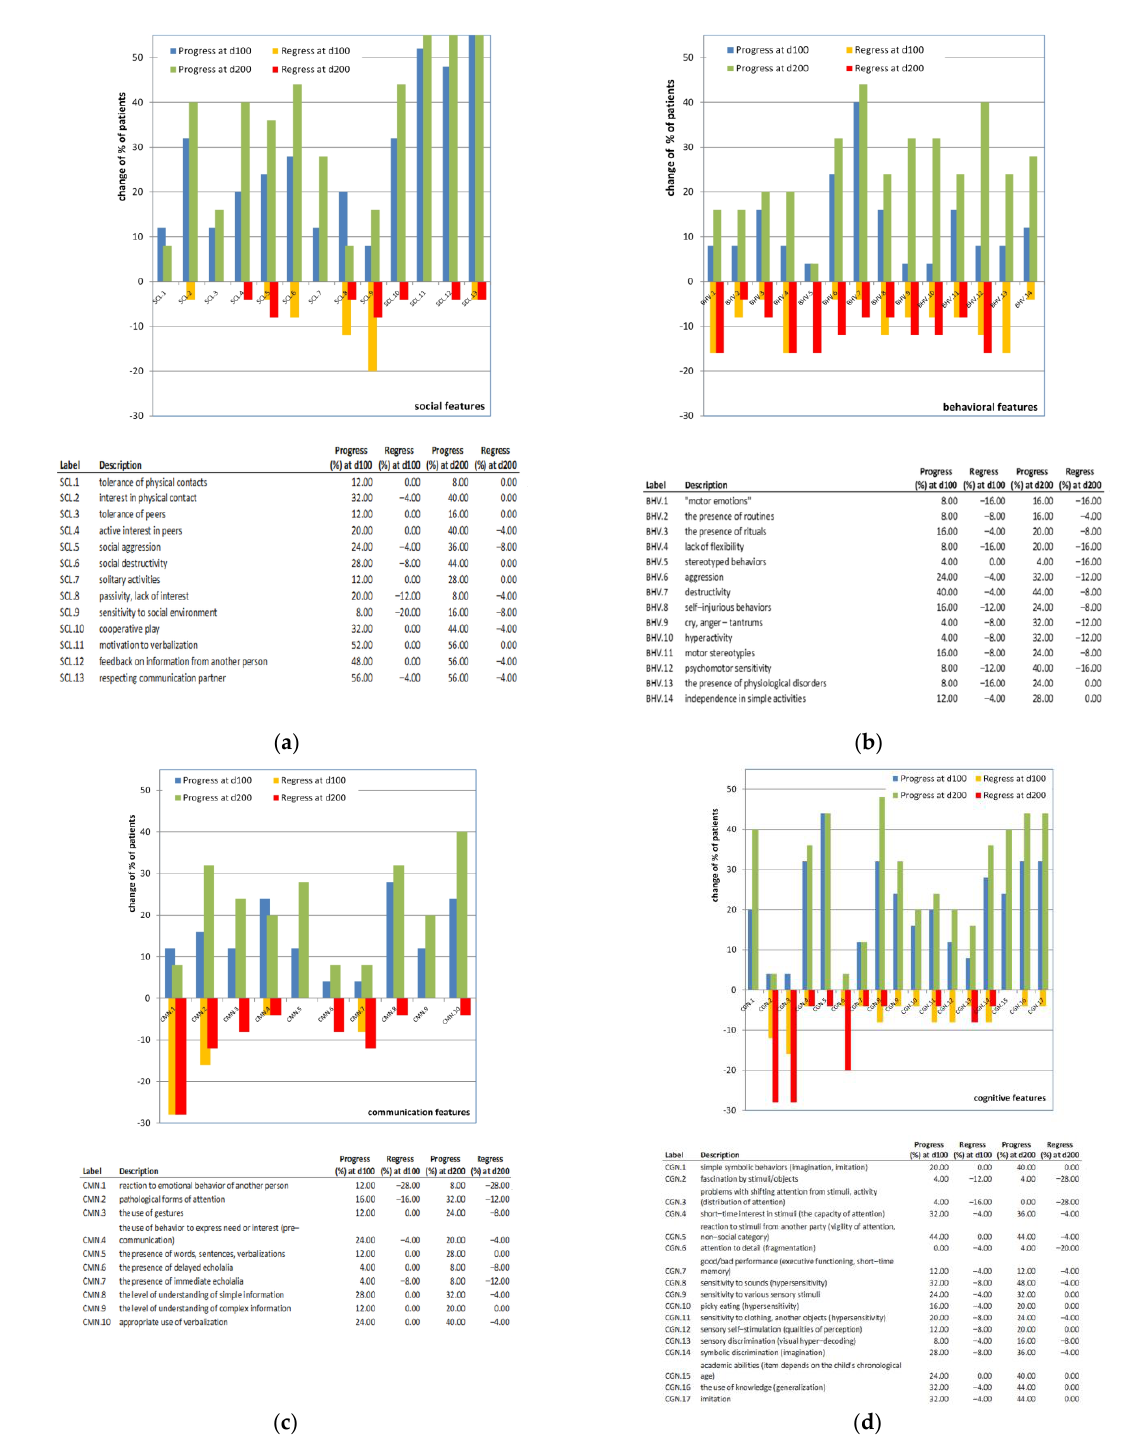
Figure 3. Progression and regression of the clinical and psychological features. Changes observed in the social ( a ), behavioral ( b ), communication ( c ), and cognitive ( d ) domains at d100 and d200 of the methylcobalamin treatment. Besides the routinely examined adverse effect of the treatment (Table S1), additional adverse effects were reported in some patients by the psychologists and parents. Among them, sleep distortion ( n = 5), behavioral disturbance towards enhanced affectivity (e.g., self-destructive behavior) ( n = 4), increased hyperactivity ( n = 6), and licking or putting in mouth inappropriate objects ( n = 3) were observed. These adverse behaviors usually occurred around four to six weeks after the treatment